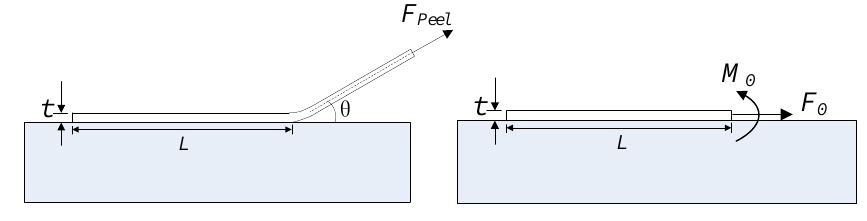
Figure 2. Schematic of a peeling test.